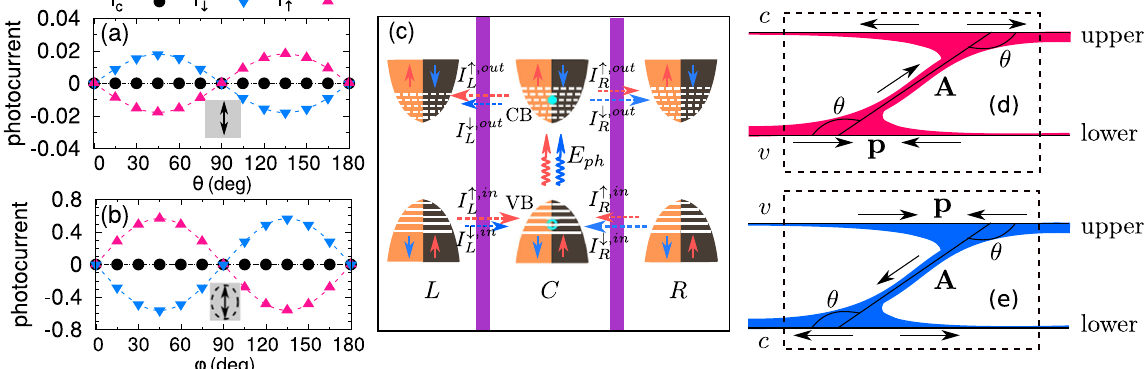
Fig. 4 Photocurrent and its generation processes in “ ZZ ” con fi guration. The spin-up ( I ↑ ), spin-down ( I ↓ ), and total charge photocurrents ( I c ) under a LPL and b EPL with photon energy E ph = 0.65 eV in “ ZZ ” con fi guration. θ ( φ ) denotes the polarization (helicity) angle of the linearly (elliptically) polarized light. φ = 45 ∘ and 135 ∘ correspond to right and left circularly polarized light, respectively. c Schematic plot of the photocurrent generation in AFM ZGNR. The orange and black areas denote the edge state bands of the nanoribbon. The real space representation of the photocurrent generation is shown by a schematic plot for d spin-up channel and e spin-down channel. “ Upper ” and “ lower ” mean the upper edge and lower edge of the ribbon, while v and c mean the locations of the edge states in the valence band and the conduction band, respectively. θ is the angle between the incoming and outgoing electron momentum p and the vector potential A